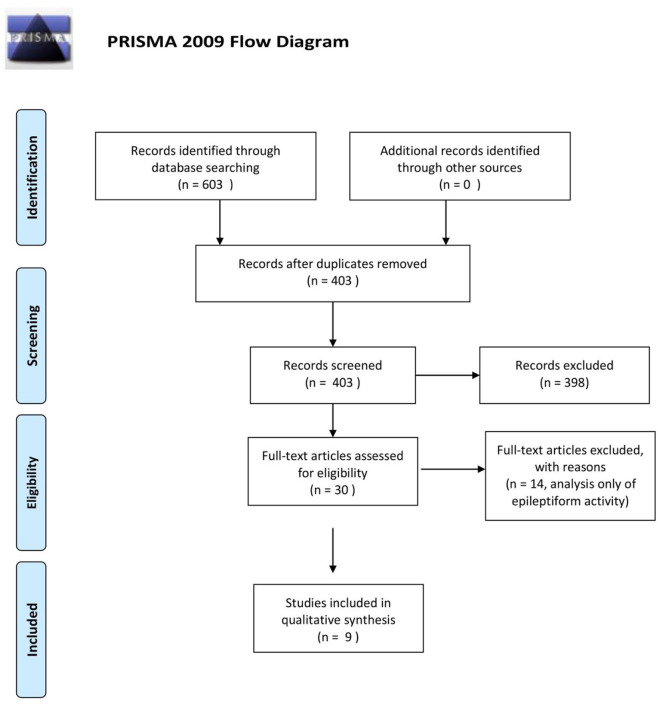
PRISMA flow diagram.